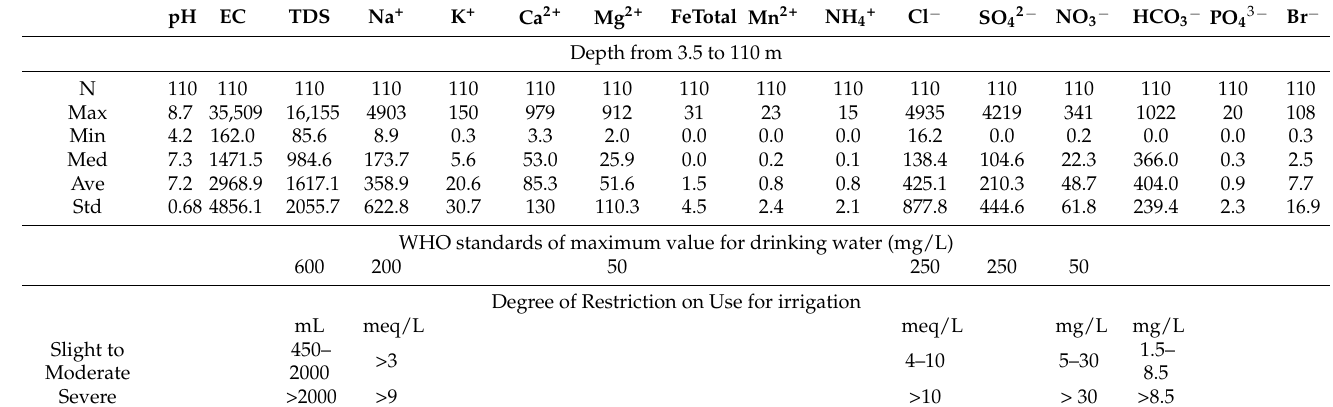
Table 1. Basic statistical descriptors of the physicochemical parameters from groundwater and surface std.—standard deviation. Units: Temperature (Temp) in ◦ C, EC in µ S/cm (25 ◦ C), total dissolved solids (TDS) and ions in